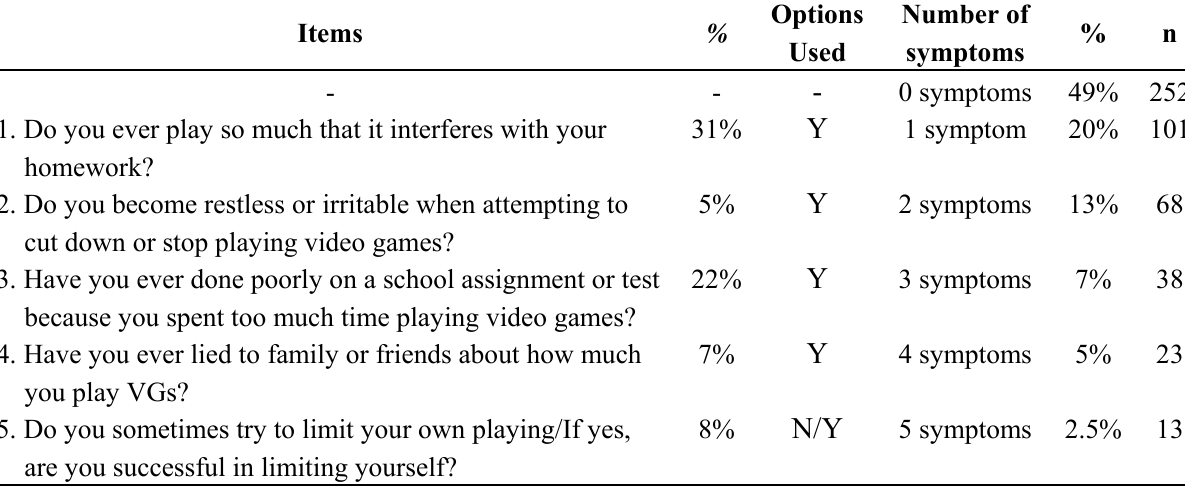
Table 3. Descriptive results for diagnostic items (Study